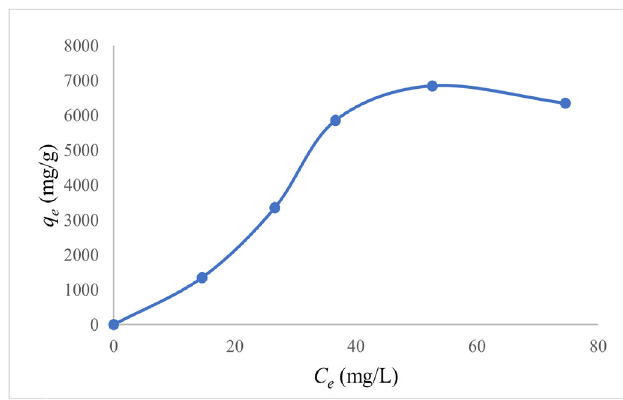
Fig. 10. Equilibrium concentration vs final concentration of